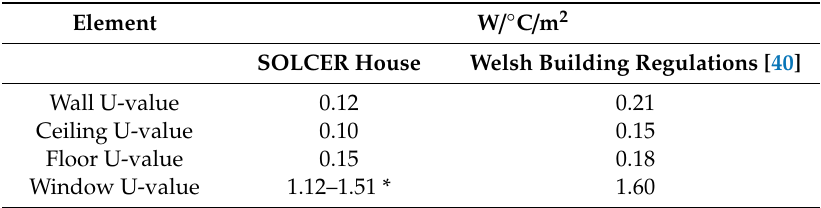
Table 2. Thermal insulation levels for the main design elements with building regulation values for